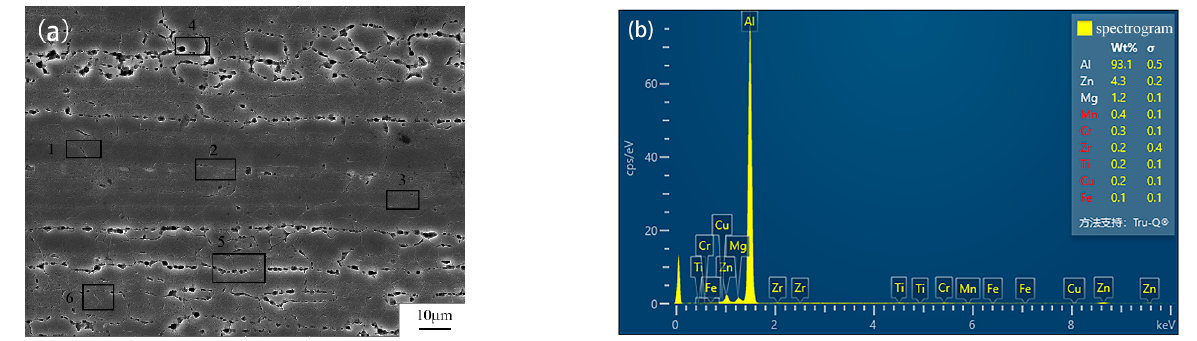
Figure 12. Microstructure and energy spectrum of 7B05-T5. ( a )microstructure and ( b ) energy spec- trum of the deformation region.